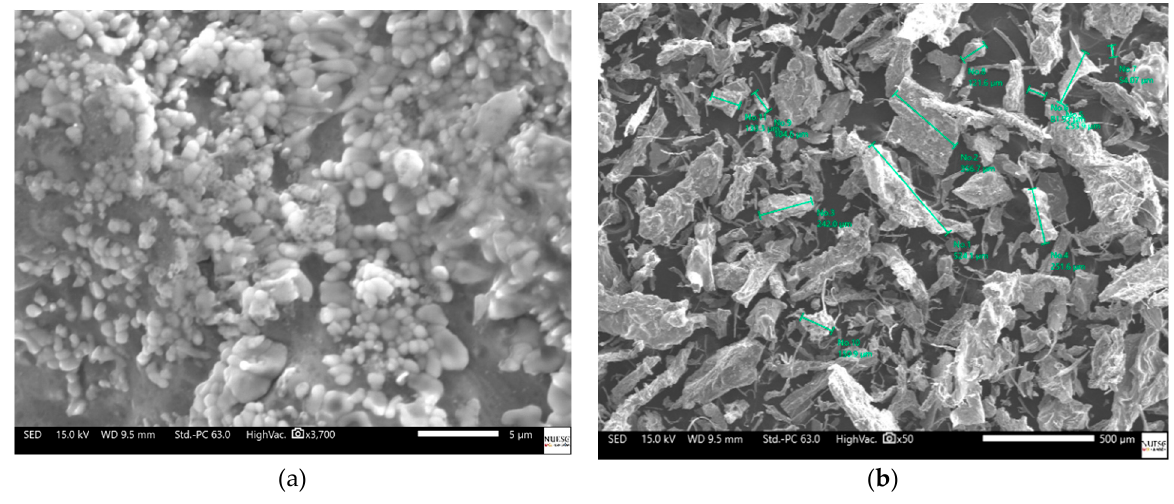
Figure 3. Scanning electron microscopy of silver nanoparticles at 3700× ( a ) and 50× ( b ). Table 4. Coefficients of Pearson’s correlation ( r ) between biological parameters (pathogenicity, LT 50 , and biomass production) and silver nanoparticle synthesis potential with entomopathogenic fungi